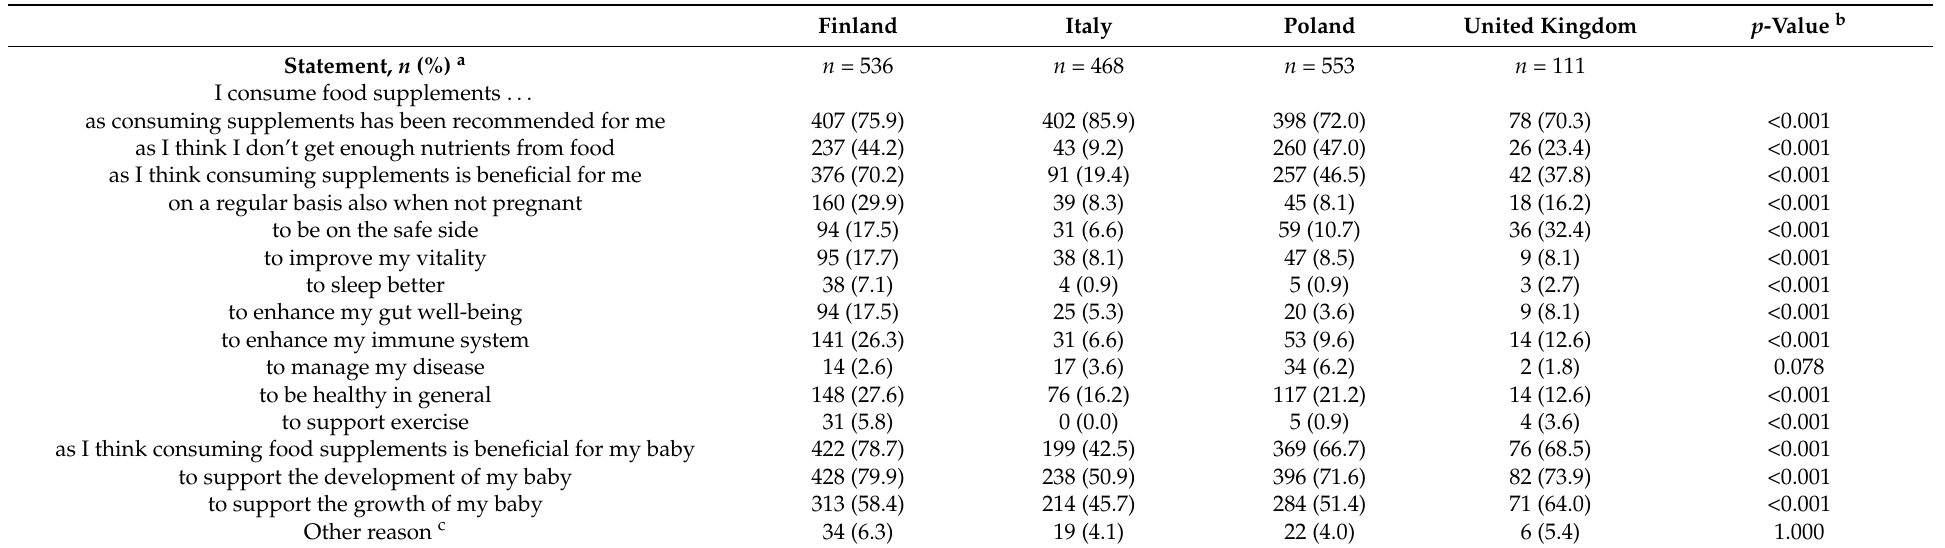
Table 2. Reasons for using food supplements during pregnancy reported by pregnant women in four European countries (proportion of women answering ‘yes’ to the